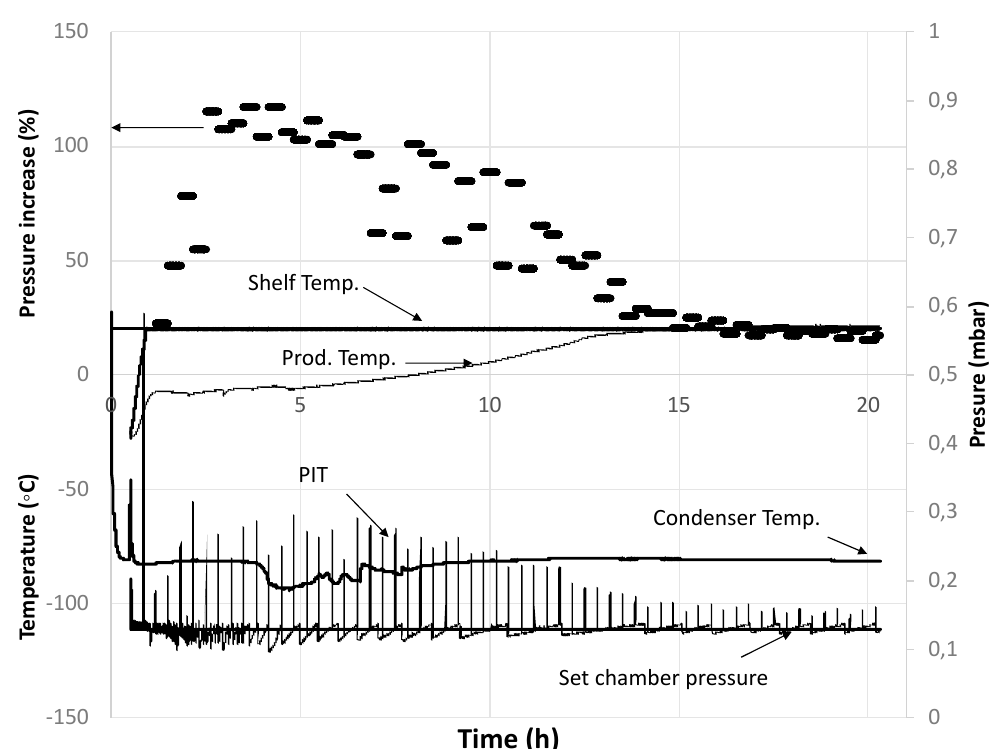
Figure 4. Busting process dynamics as evaluated from photographs taken during the freeze-drying process of whole nontreated blueberries.